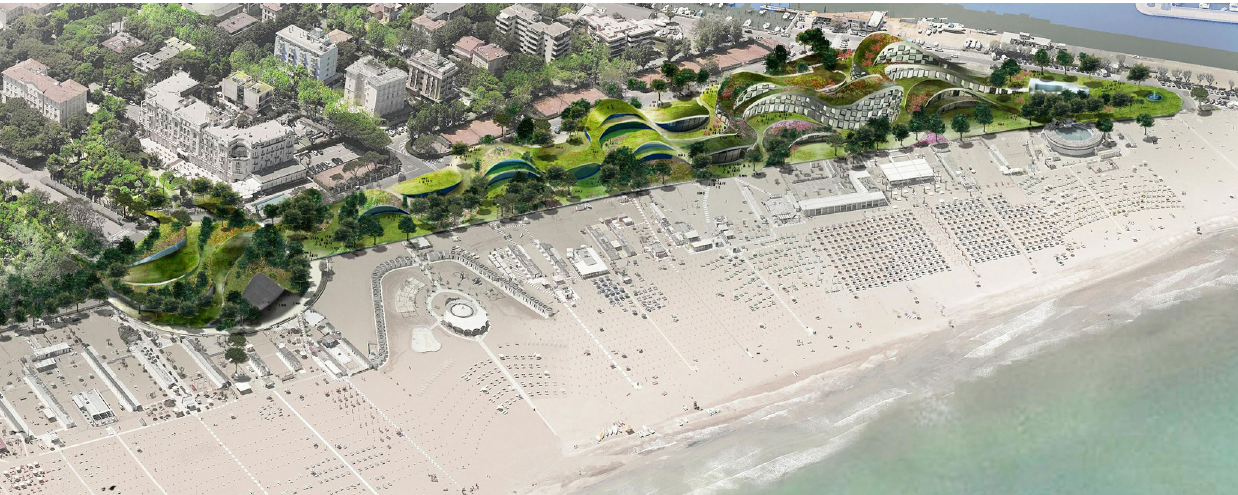
Figure 3. Prototype design of Parco del Mare project in Rimini. Adapted from JDS